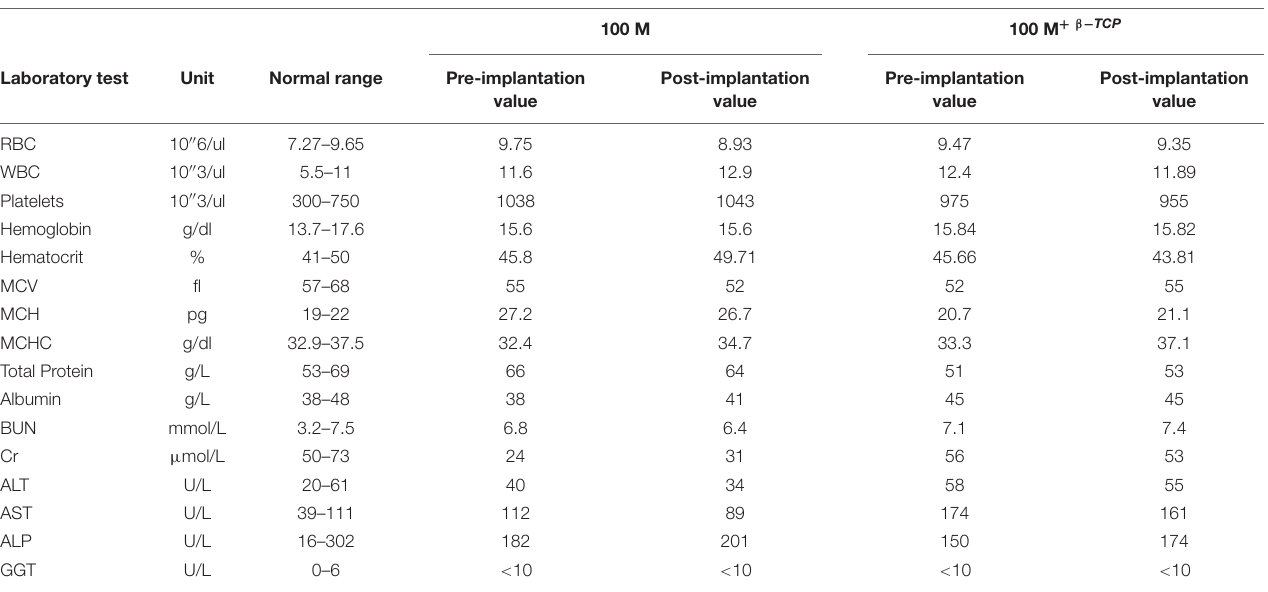
TABLE 2 | Hematology and biochemistry blood analysis.